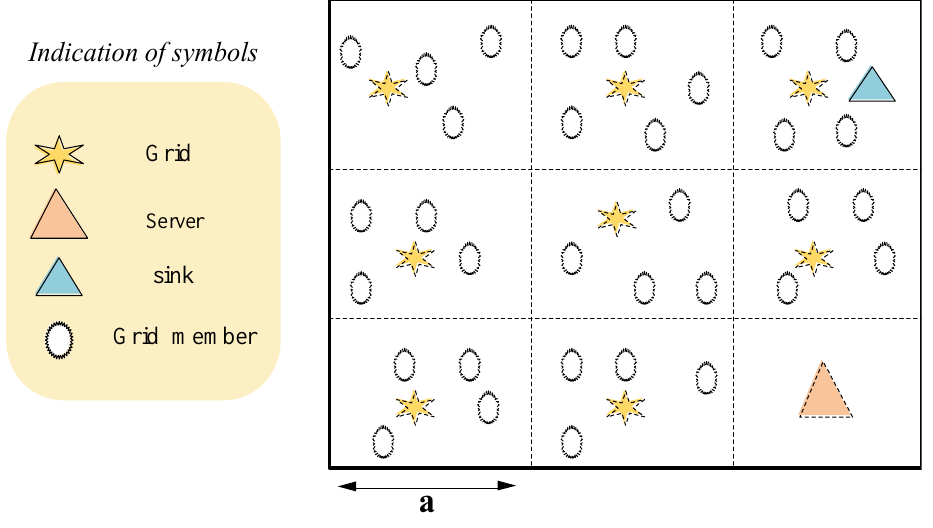
Figure 2. Design of network model.